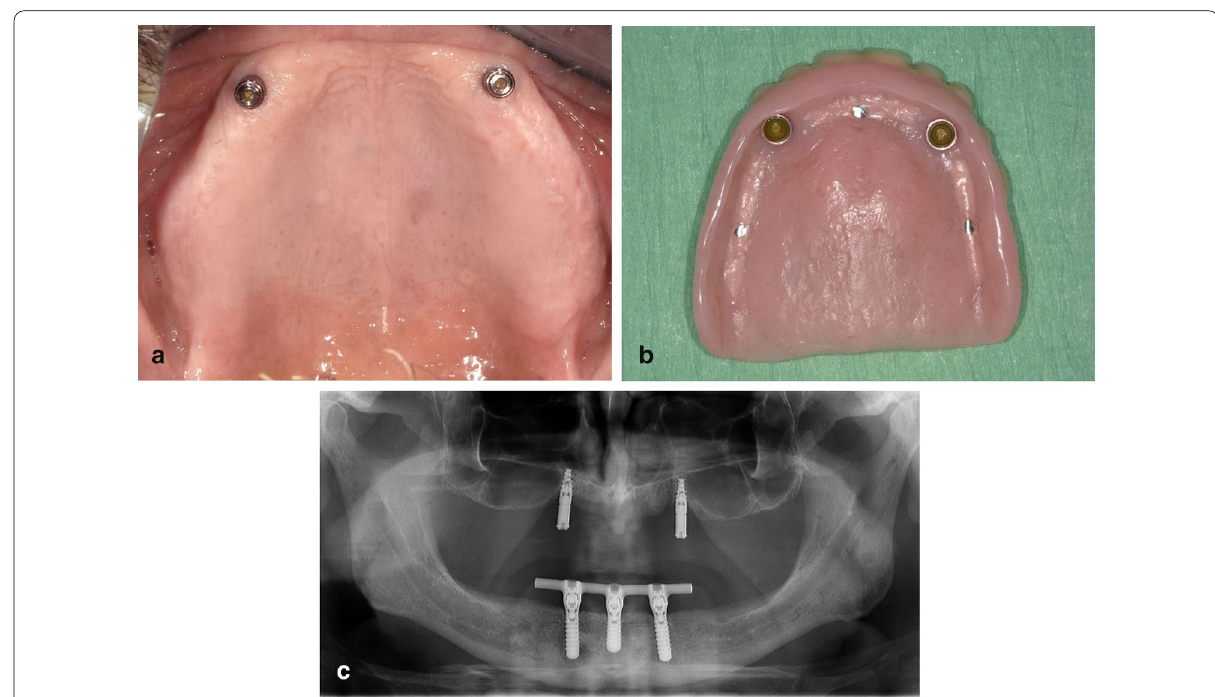
Fig. 2 a Patient with a maxillary IOD after 12 months. b Overdenture of the same patient. c Panoramic radiograph of the same